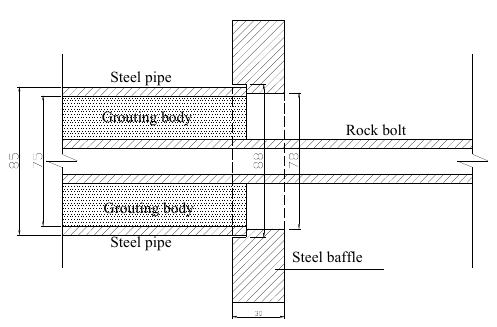
Figure 7. Schematic diagram of rock bolts with steel baffle (unit: mm).